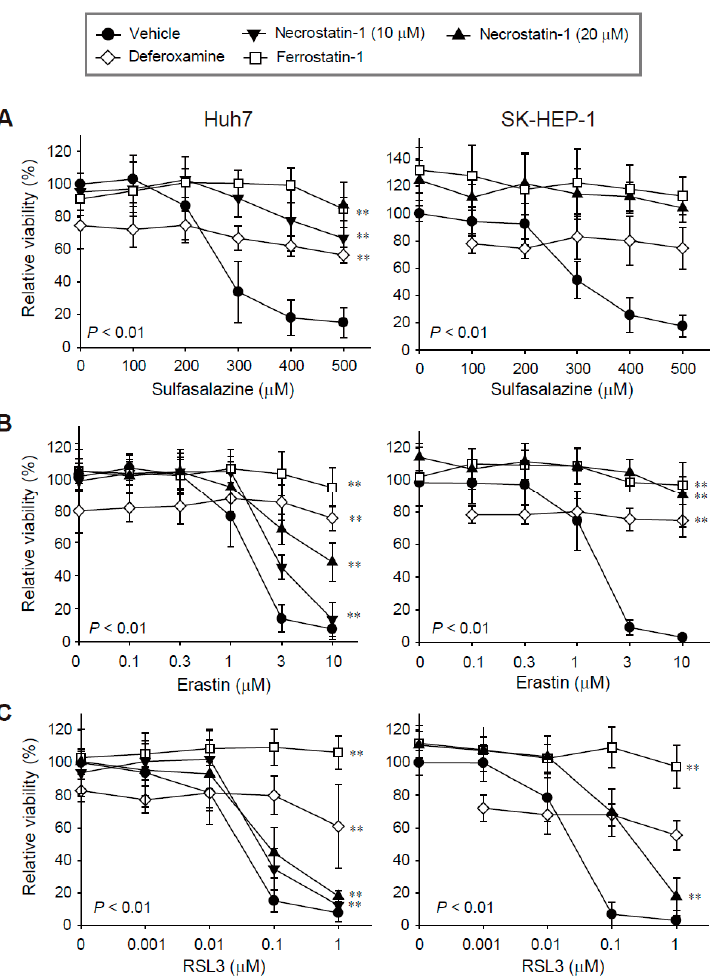
Figure 1. Decreases in cell viability induced by sulfasalazine, erastin, or RSL3 were prevented by pre-treatment with necrostatin-1, deferoxamine, or ferrostatin-1. Huh7 (left) and SK-HEP-1 (right) cells were treated with vehicle (circle), necrostatin-1 (inverted triangle for 10 μ M; triangle for 20 μ M), 100 μ M deferoxamine (iron chelator, diamond), or 20 μ M ferrostatin-1 (lipophilic antioxidant, square), for 1 h. Subsequently, sulfasalazine ( A ), erastin ( B ), or RSL3 ( C ) was applied for 24 h in a dose-dependent manner; cell viability was measured with a CellTiter-Glo ® (Promega, Madison, WI, USA) assay. Each experiment was repeated 3–6 times in triplicate. Data are expressed as means ± SDs. ** p < 0.01, vehicle-treated versus inhibitor-treated.